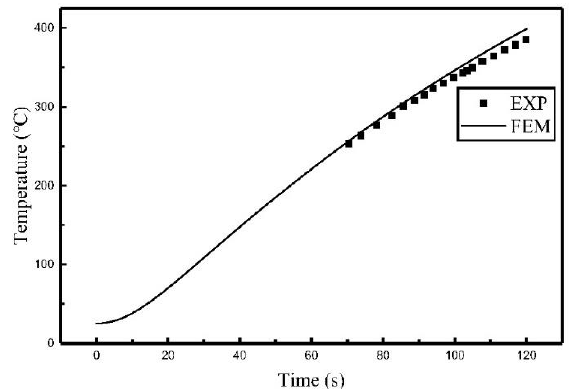
Figure 7. Comparison of the temperature histories of C 1 .